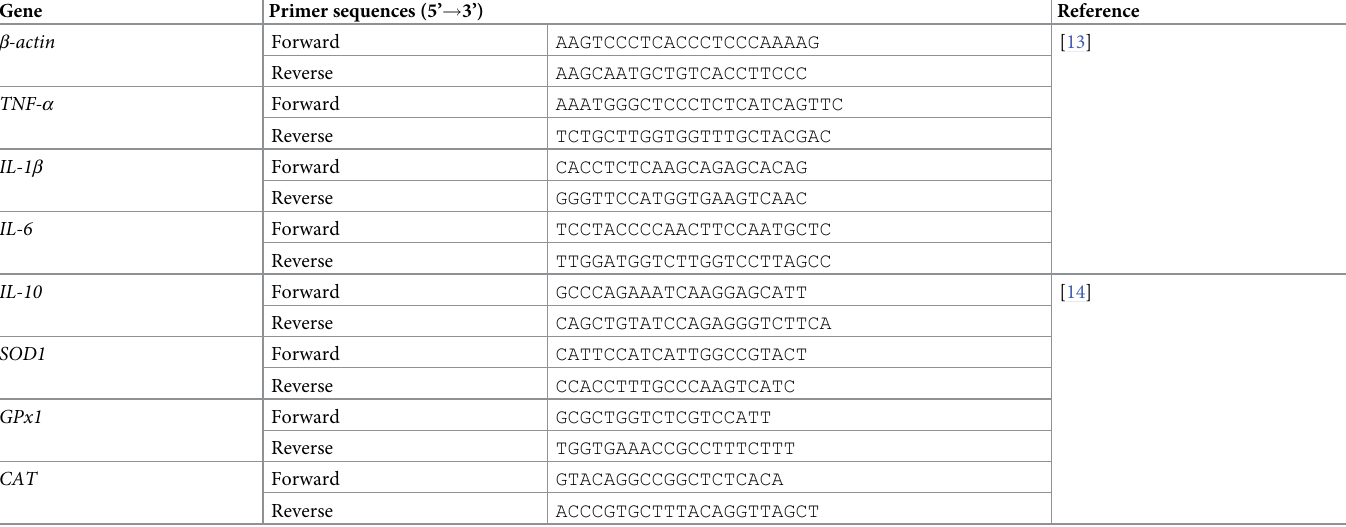
Table 1. Primer sequences of inflammatory and oxidative stress-related cytokines used for quantitative reverse transcription polymerase chain reaction (RT- qPCR).